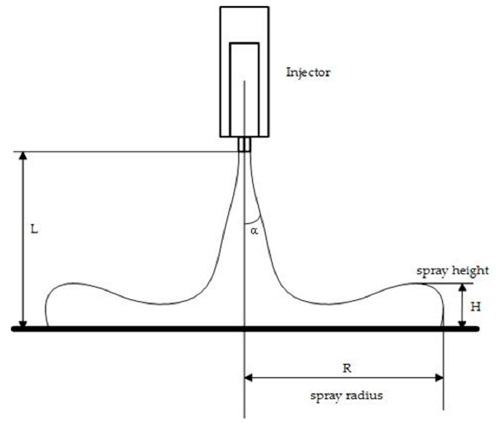
Figure 2. Spray-wall impingement parameter.